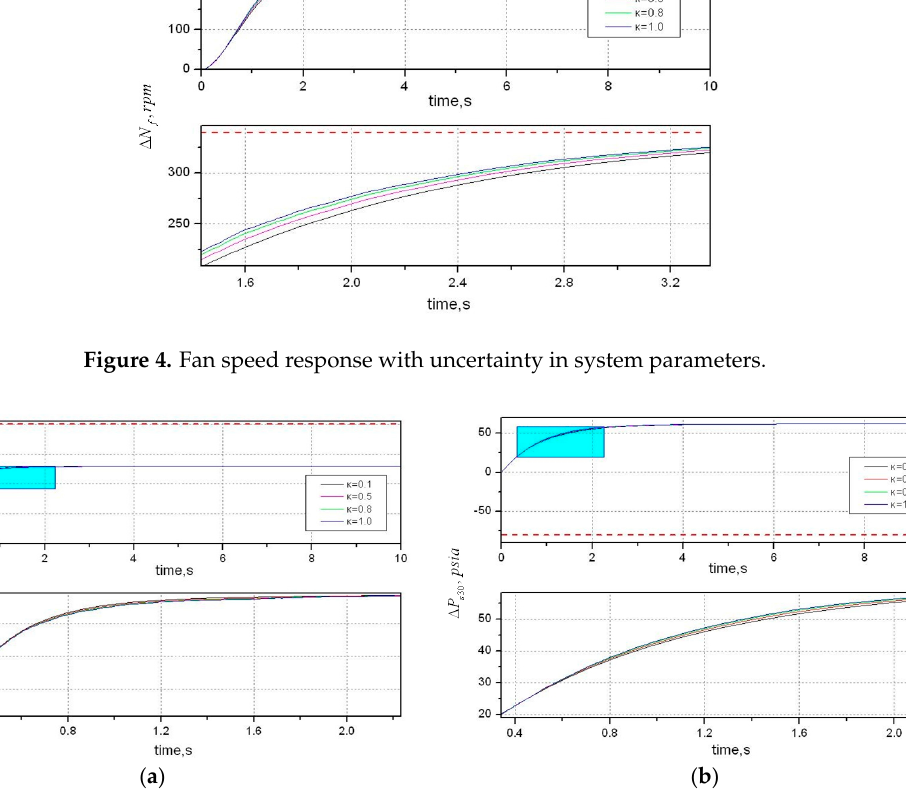
( b ) Figure 6. Fan speed response with uncertainty in system parameters. ( a ) Case 1 by taking 0.1,0.5,0.8, β = ( b ) Figure 7. High-pressure turbine outlet temperature response with uncertainty in system parameters. ( a ) Case 1; and ( b ) case 2.